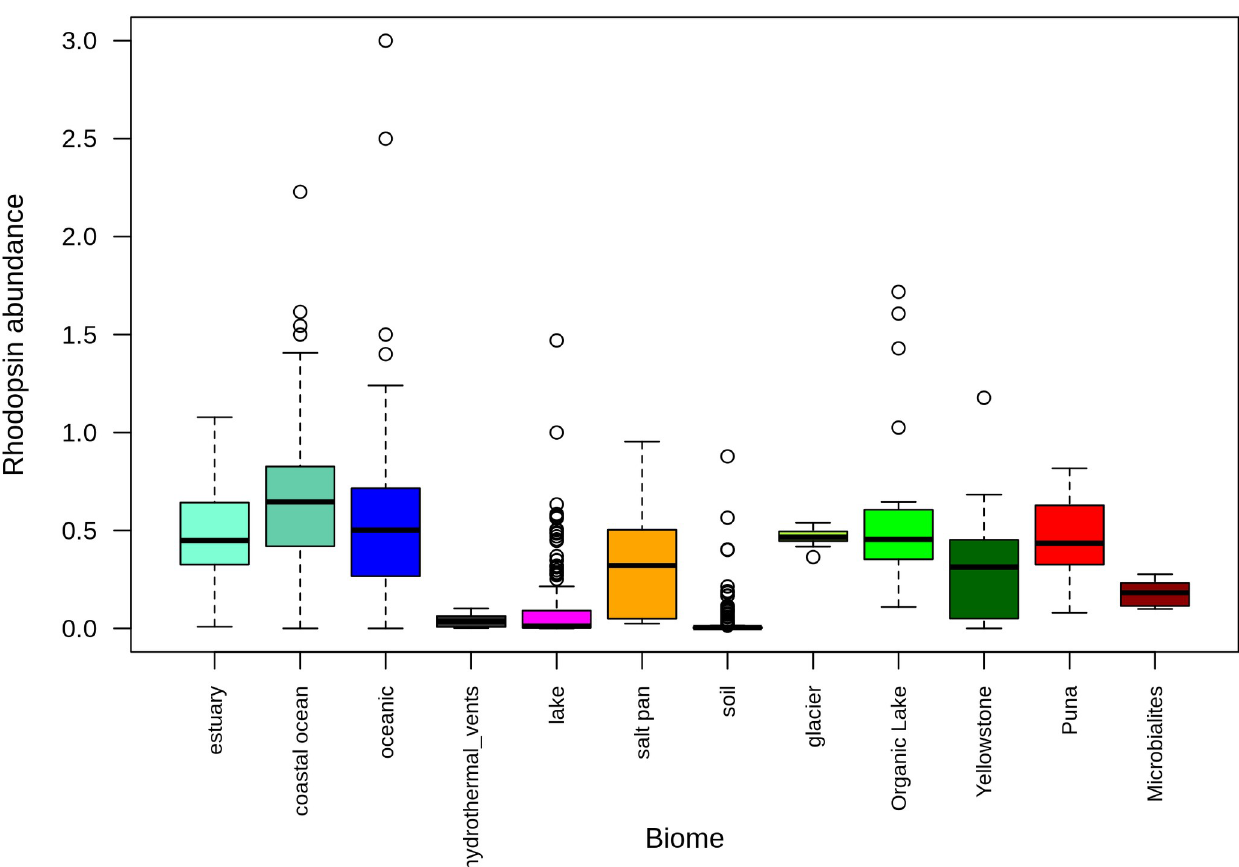
Fig 6. Rhodopsin abundances in metagenomes. Data from 1063 metagenomes, standardized to RecA and Rad51 abundances, and grouped by category Metagenomes from this work and other HAAL sites are included as “Puna”.